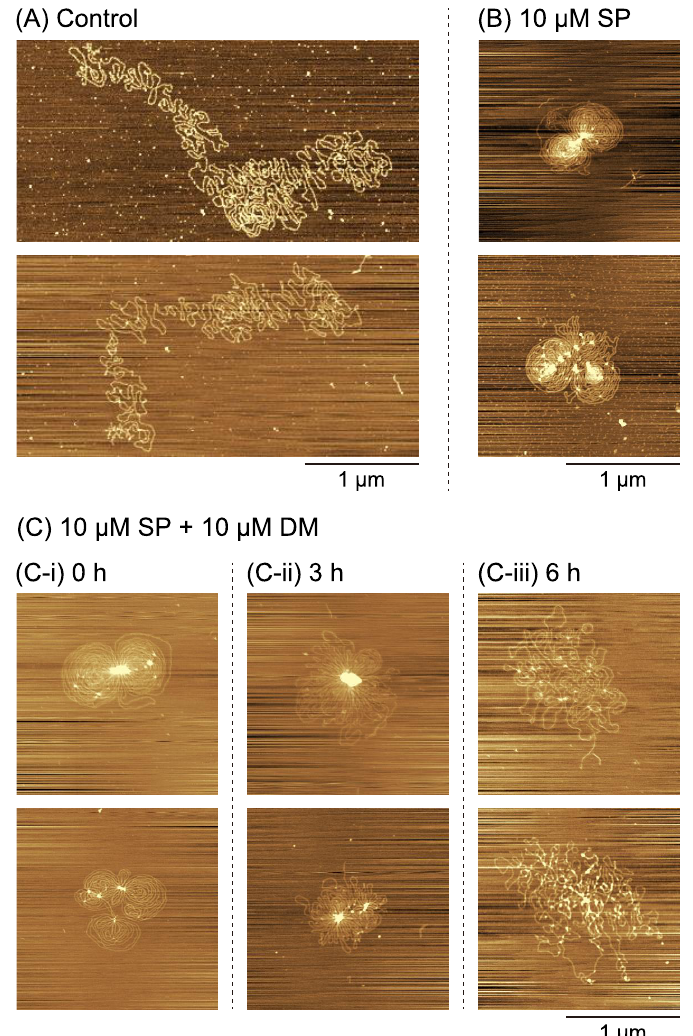
Figure 4. Atomic force microscopy images of T4 GT7 DNA. T4 GT7 DNA in the presence of various concentrations of spermine (SP) and daunomycin (DM): ( A ) control (3.5 µ M SP) without preincubation, ( B ) 10 µ M SP without preincubation; ( C ) 10 µ M SP and 10 µ M DM without preincubation ( C-i ), with preincubation at room temperature (24 ◦ C) for 3 h ( C-ii ) and with preincubation at room temperature (24 ◦ C) for 6 h ( C-iii ). The DNA concentration was fixed at 0.6 µ M in nucleotide unit. The scale bar is 1 µm and applies to all subfigures.